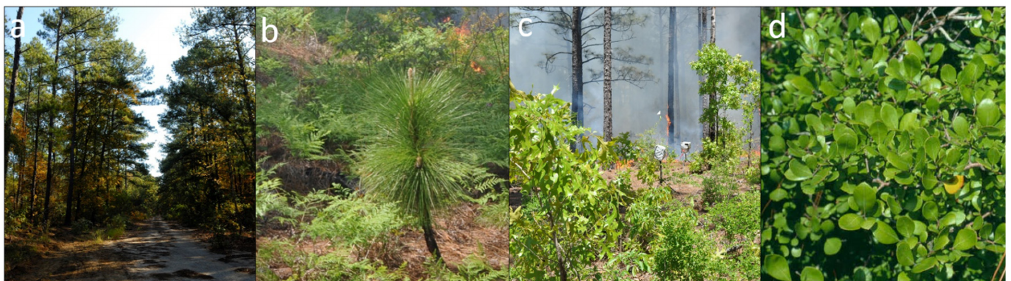
Figure 1. Vegetation of the Carolina sandhills ecological region at Ft. Jackson: ( a ) view of overstory longleaf and loblolly pine trees from ground level; ( b ) longleaf pine seedling in grass stage; ( c ) understory view of turkey oak and sparkleberry; ( d ) close-up view of sparkleberry foliage.